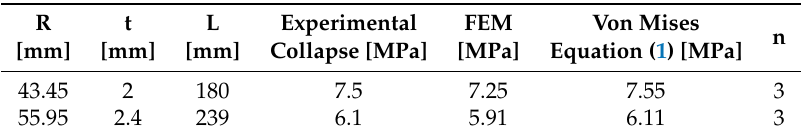
Table 5. Comparison with BlueRobotics data [38].